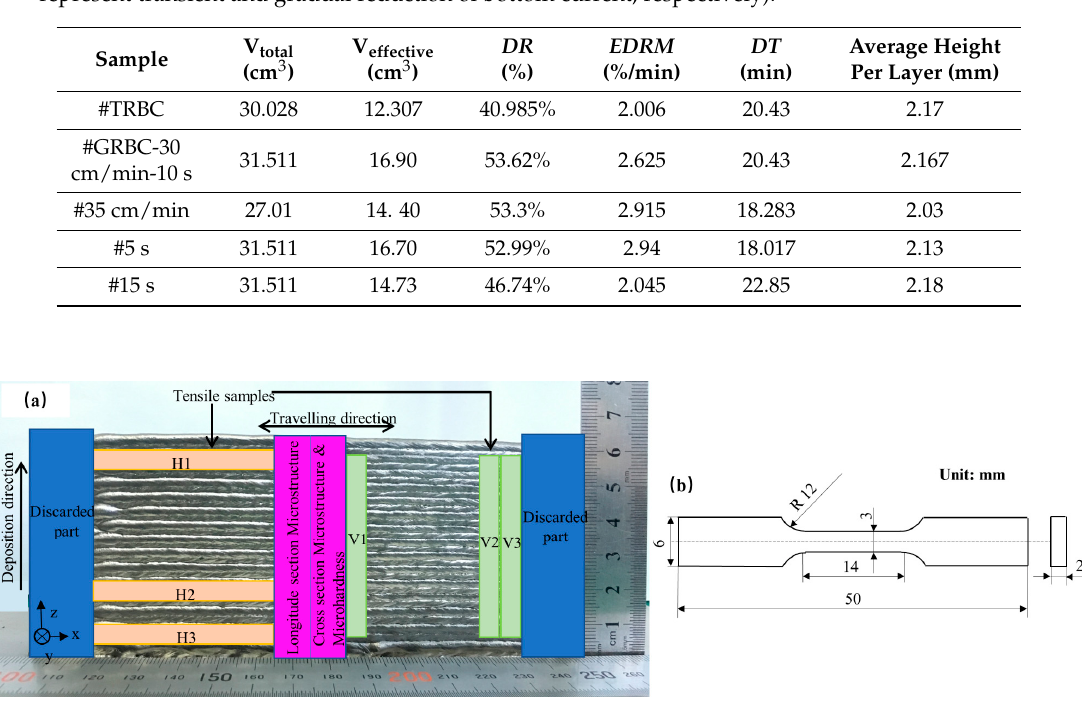
Figure 2. ( a ) Extraction locations on each wall to obtain microstructure, microhardness, and tensile samples; ( b ) tensile specimen